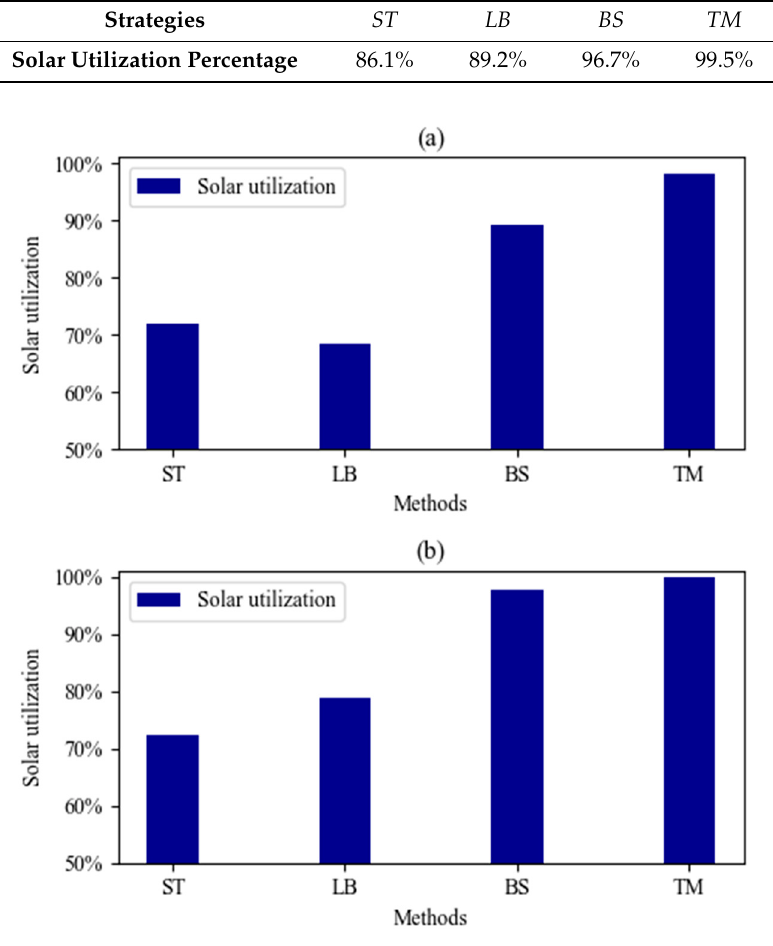
Figure 4. Solar utilization percentage: ( a ) sunny day; ( b ) cloudy (rainy) day.